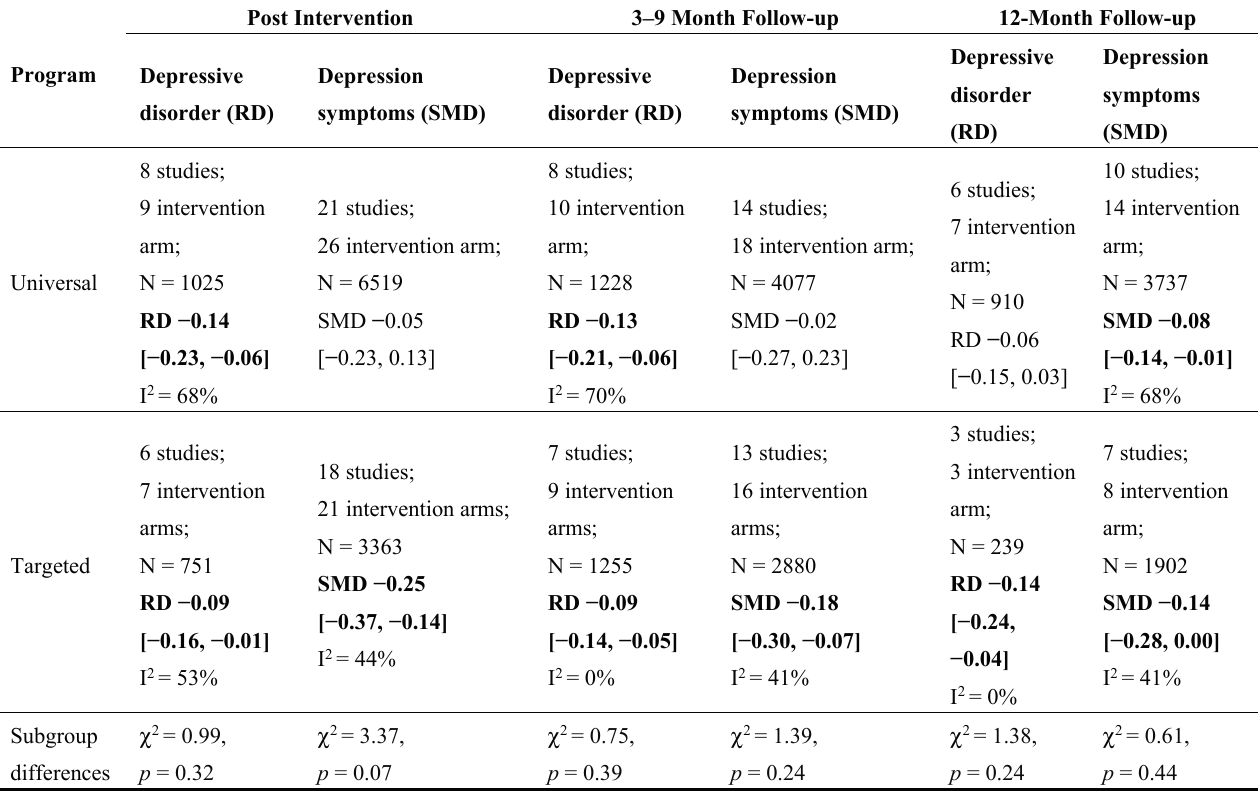
Table 5. Summary of meta-analysis results for approach to prevention programs analysed by population.